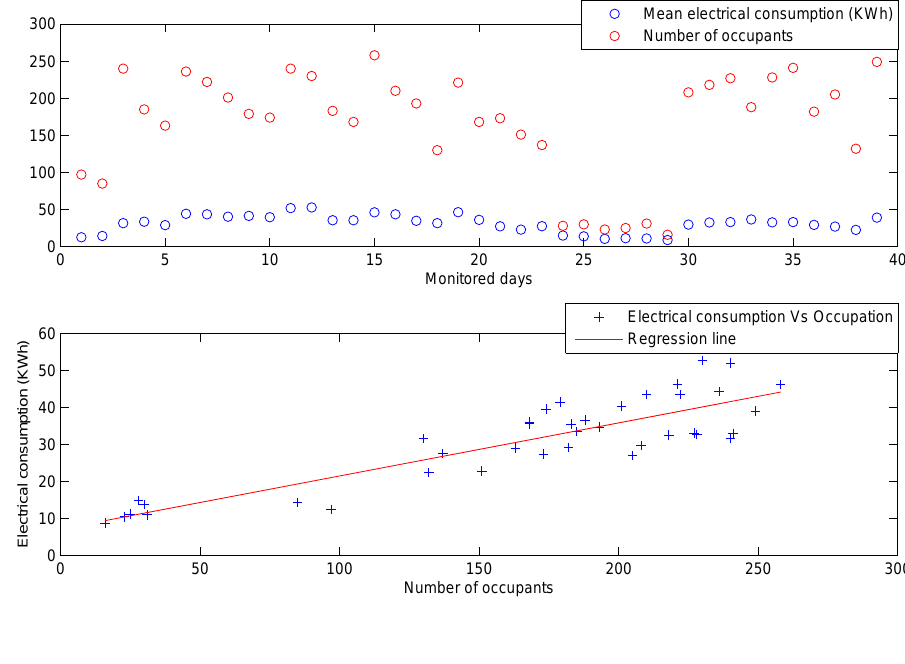
Figure 14. Evolution of the electrical power consumption and the occupancy level.